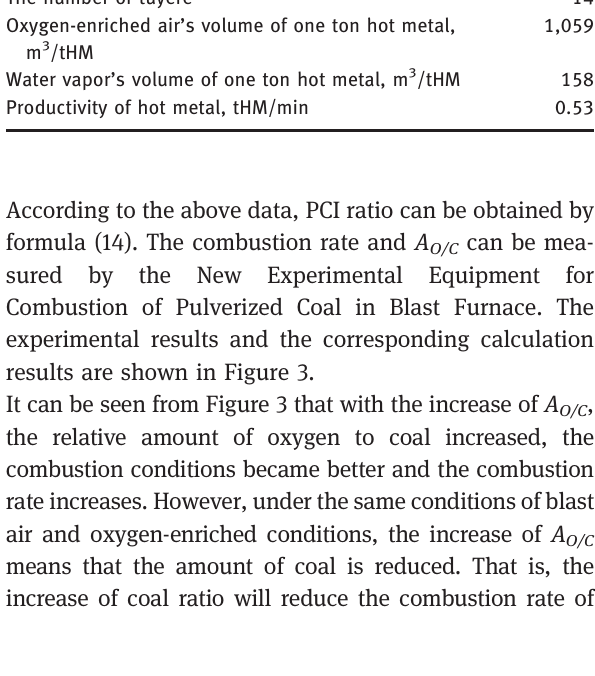
Table 2: Process parameters of oxygen blast furnace.